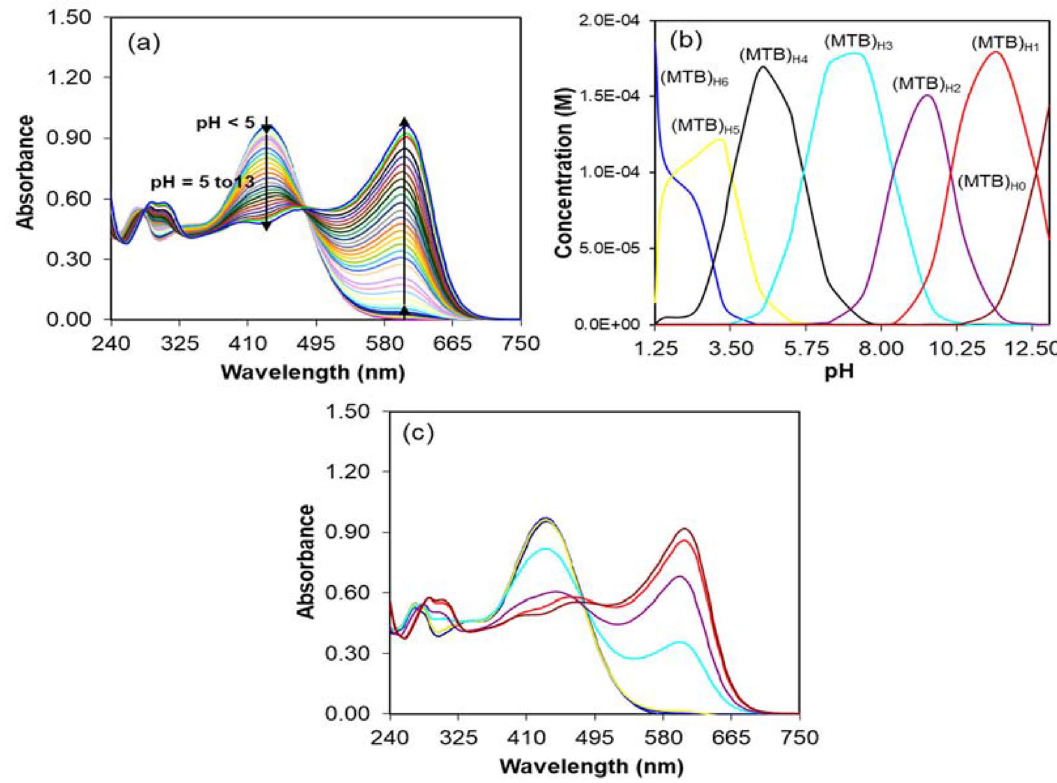
Figure 2. ( a ) UV–Visible spectra of MTB during the acid–base titration in the range of pH 1.25–13, ( b ) concentration profiles, and ( c ) spectral profiles resolved by the